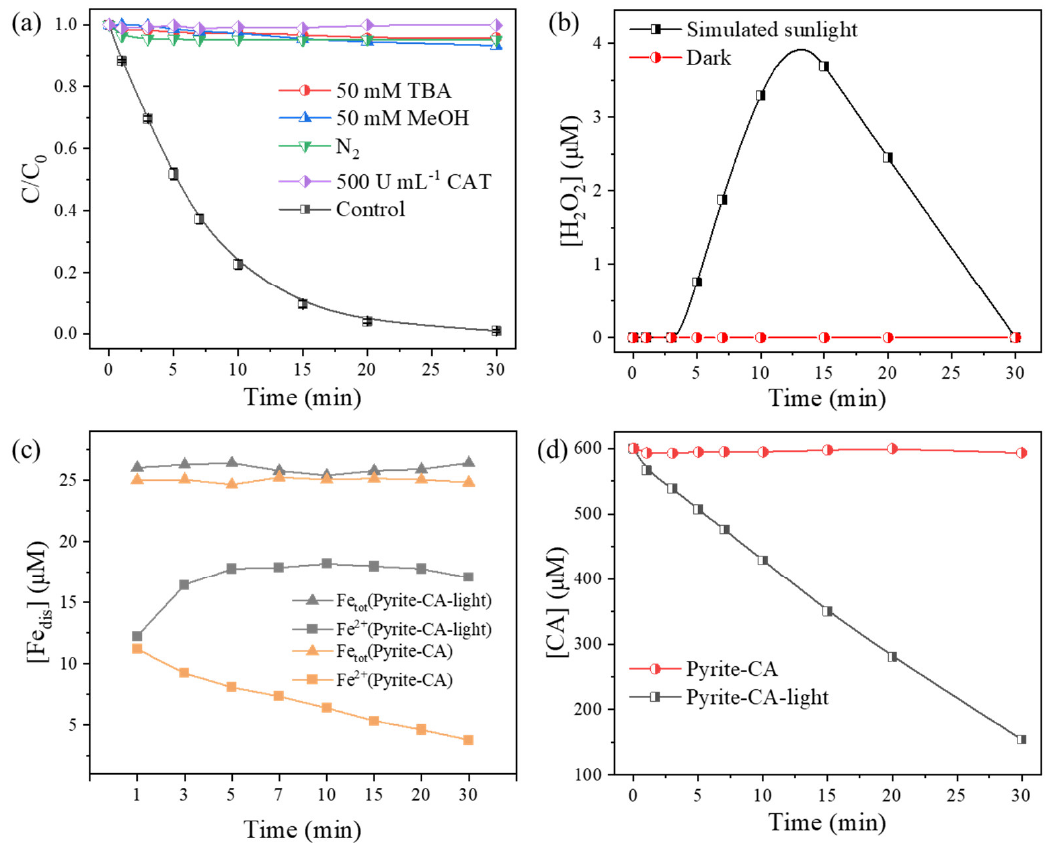
Figure 3. ( a ) Effect of various scavengers and anoxic solution on APAP degradation in the pyrite– CA–light system. ( b ) The concentration of H 2 O 2 produced under simulated sunlight or in the dark. ( c ) Change in Fe(II) concentration and Fe(III) in the pyrite–CA–light system. ( d ) Change in CA con- centration under simulated sunlight or in the dark. Initial conditions: [pyrite] = 0.1 g L −1 , [APAP] = 30 μM, [CA] = 0.6 mM, pH ini = 6.